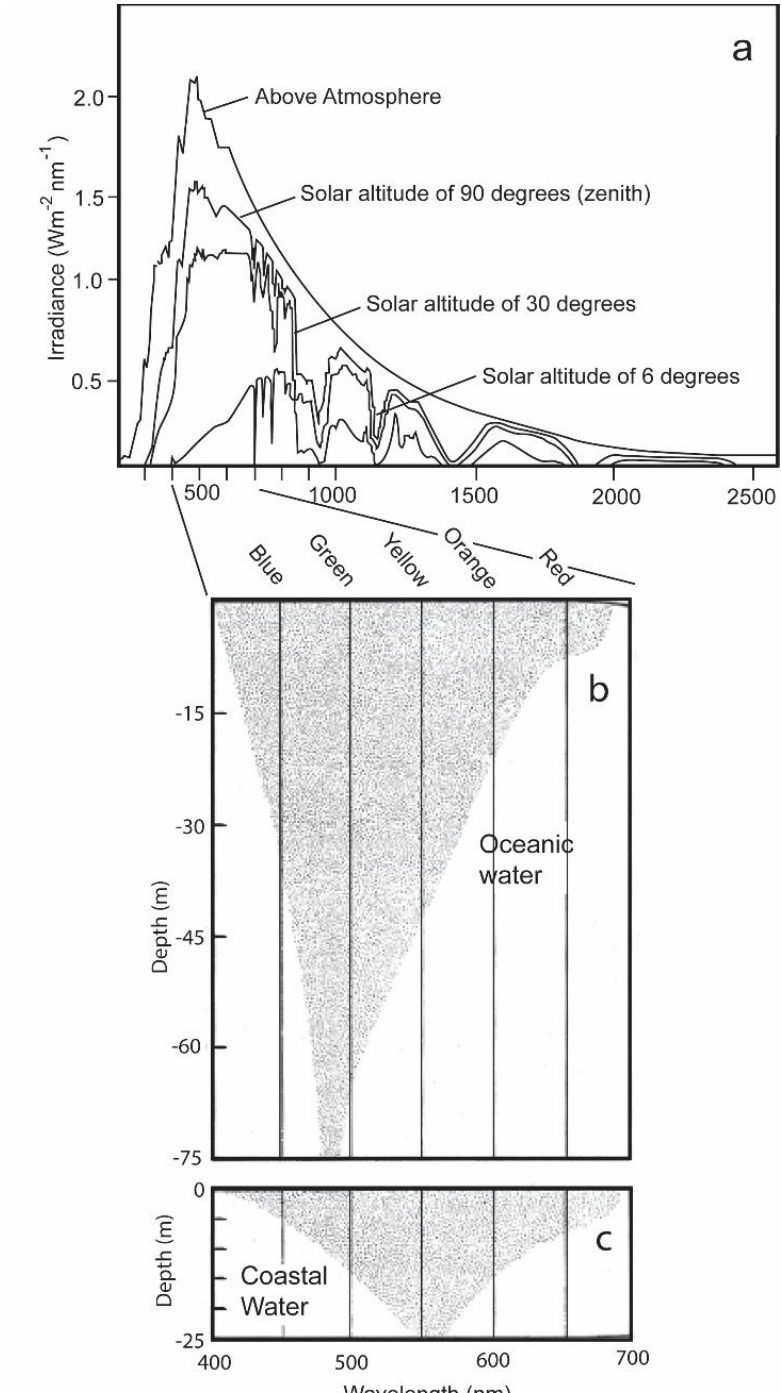
Figure 2. ( a ) Spectral distribution of solar irradiance present from the sun above and within the atmosphere and different solar altitudes with the sun being at its zenith; ( b ) the extinction of daytime irradiance as a function of wavelength with increasing depths in clear oceanic water; ( c ) the extinction of daylight in coastal water with increased turbidity and plankton biomass ( c ) [9]. The rods and cones of juvenile lemon sharks have both pigments and are thus adapted for daytime and nighttime irradiance conditions. The sensitivity of these sharks can be determined by threshold experiments, during which the subject is exposed to a wide